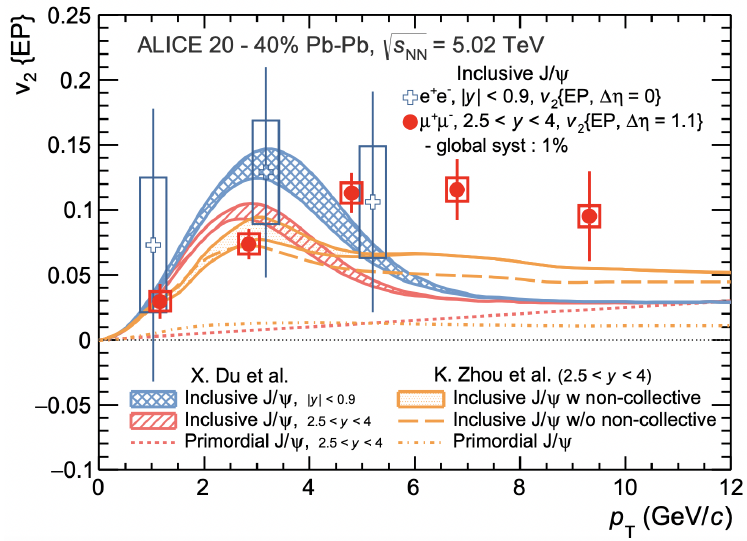
Figure 14. J / ψ elliptic flow v 2 as a function of p T in Pb + Pb collisions for the 20–40% centrality class [75]. The red (blue) data points represent the J / ψ → e + e − ( J / ψ → µ + µ − ) decay channels. The data are compared with different theoretical models described in the text. Reprinted with permission from American Physical